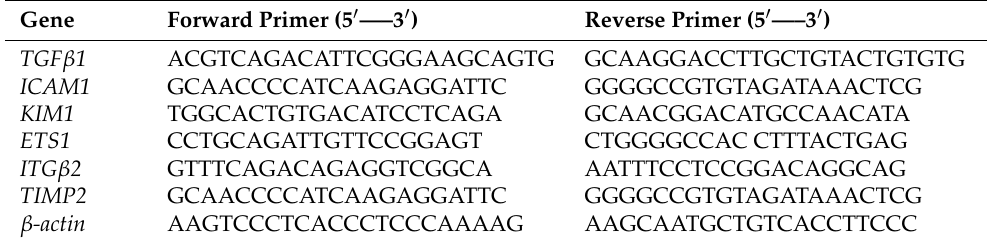
Table 1. Primers used for real-time